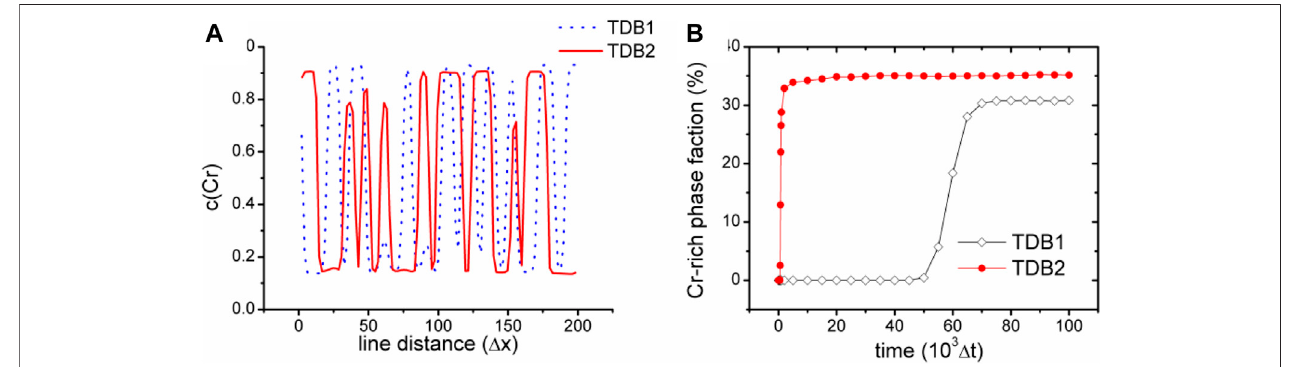
FIGURE4| (coloronline) (A) Crconcentrationalongthetwoblacklineshighlightedin Figures3C,F(B) variationofphasefractionwithCrconcentrationhigherthan 0.5 with